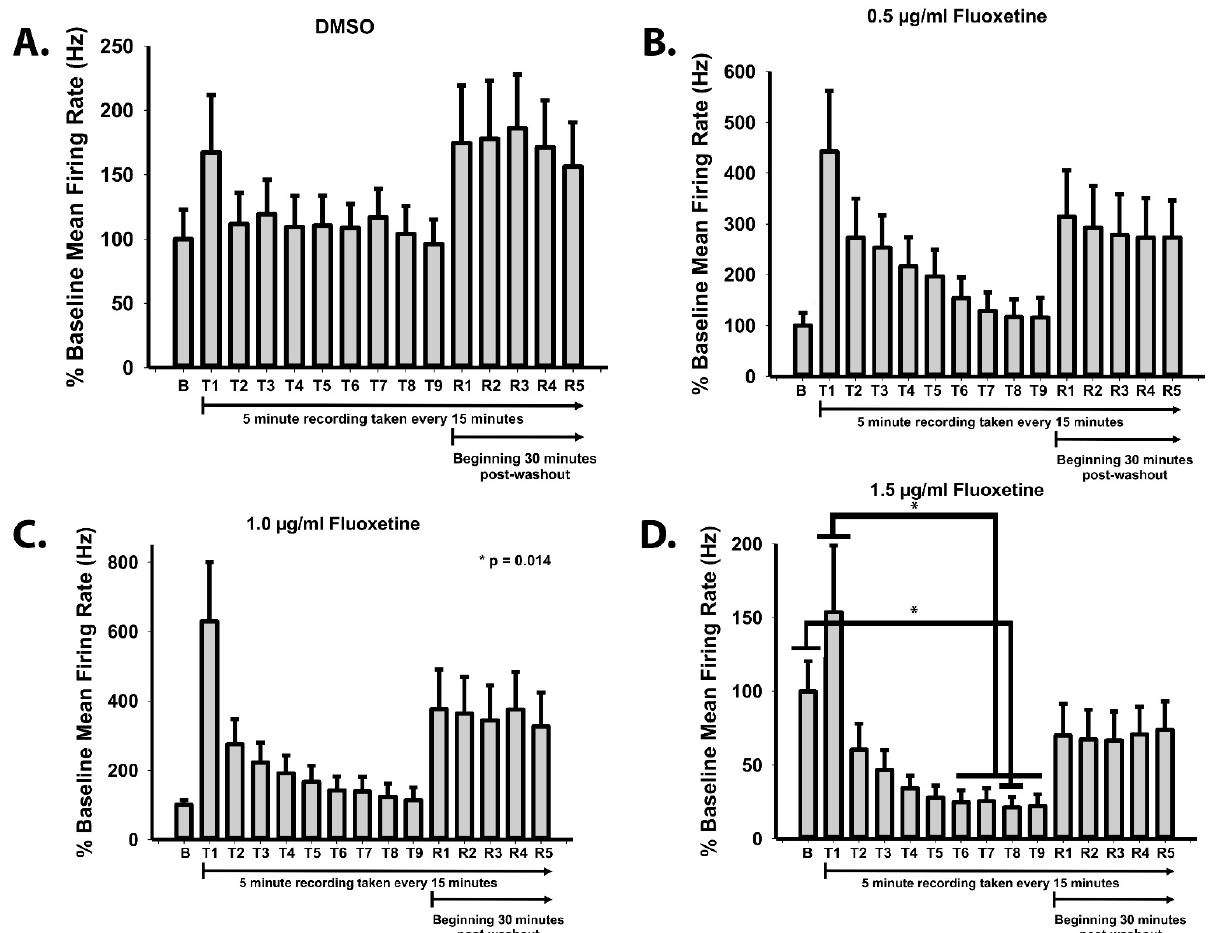
Figure 4. Fluoxetine reversibly suppresses spontaneous action potentials. Multielectrode array recordings of human cortical spheroids dissociated onto MEA plates. A baseline recording (labeled B) was measured to determine the normal firing rate before adding fresh media with either DMSO solvent control or increasing concentrations of fluoxetine. Neural activity was recorded every 15 min for 5 min for a total of 2 h (T1-T9). After 2 h, the drug was washed out with fresh neuronal media and after 30 min 5 recovery recordings (R1-R5) were taken every 15 min for 5 min each. ( A ) DMSO does not significantly alter firing rate. ( B ) 0.5 µ g/mL FLX does not alter firing rate. ( C ) 1 µ g/mL FLX does not alter firing rate. ( D ) 1.5 µ g/mL FLX significantly decreases firing rate from baseline and the initial spike in activity in response to fresh media between T6-T9. n = 12 independent MEA wells from 2 independent human cortical spheroid cultures. * p < 0.05, One-way ANOVA.